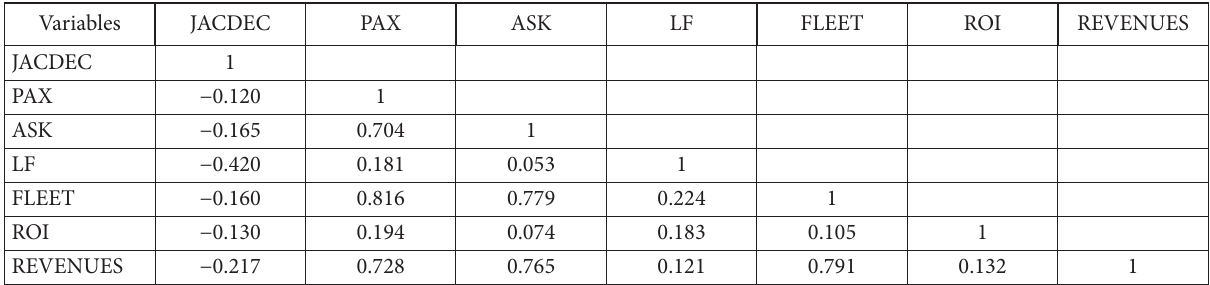
Table 2. Correlation